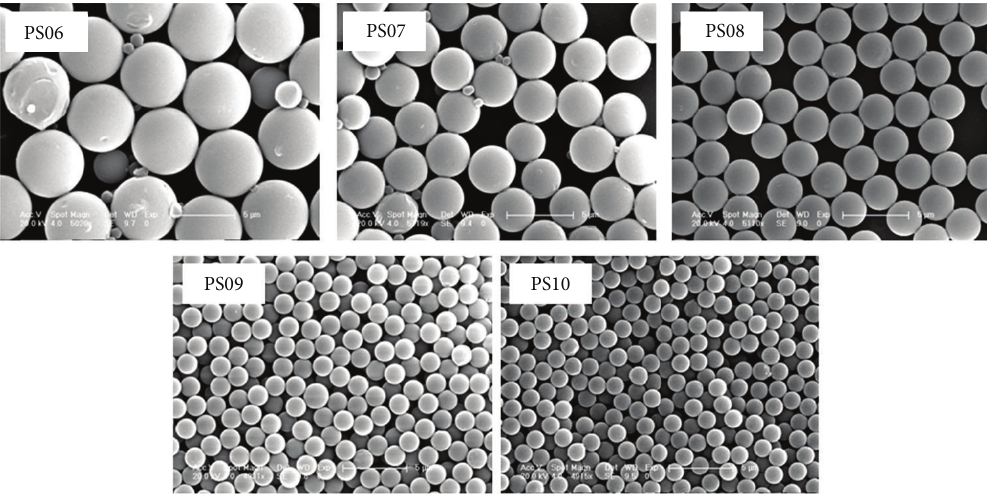
Figure 2: SEM images of polystyrene microspheres synthesized with different dosages of